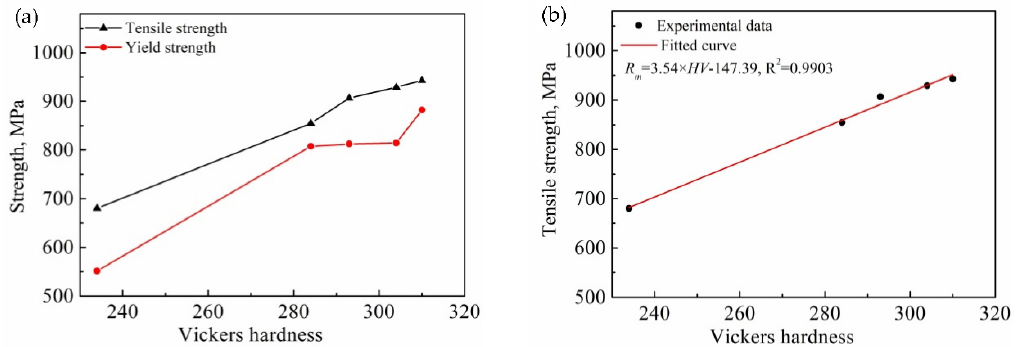
Figure 6. The relation between strength and hardness of Gr.4 strip: ( a ) curves of hardness and strength and ( b ) fitting curve of tensile strength and hardness.